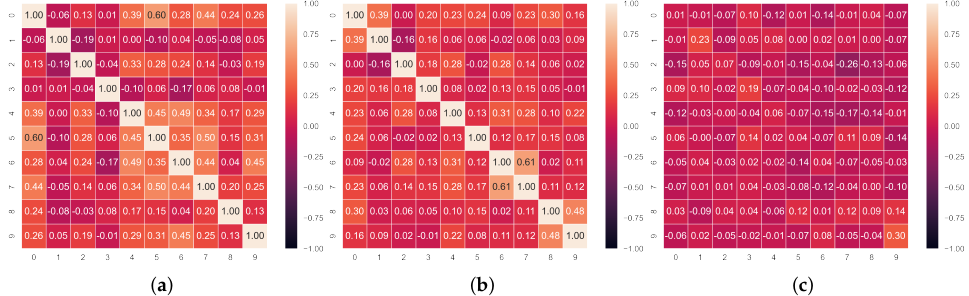
Figure 4. Correlation matrices between the honest and/or faked items in the JIS dataset. ( a ) Correla- tion matrix of faked responses. ( b ) Correlation matrix of honest responses. ( c ) Correlation matrix of honest and faked responses.